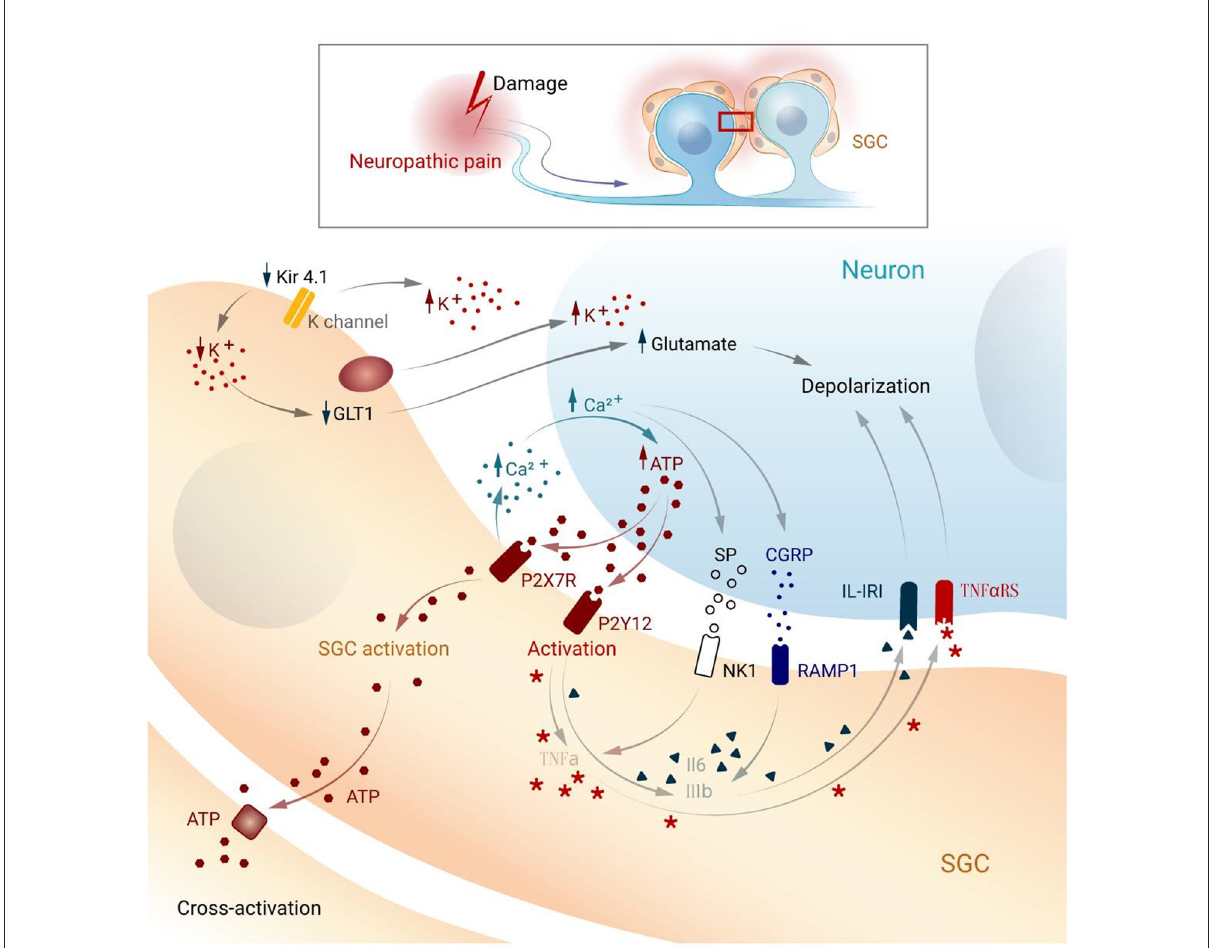
FIGURE2 Possible mechanism underlying activation and cross-activation in SGCs and neurons while pain. SGC, satellite glial cell; Kir4.1, potassium channel; GLT1, glutamate transporter; P2X7R, P2X purinoceptor 7; P2Y12, purinergic receptor; NK1, Neurokinin 1; RAMP1, Receptor activity modifying protein 1; IL1- β , interleukin-1 beta; IK-IR, Interleukin-1 receptor; TNF- α , tumor necrosis factor-alpha; TNFaRS, tumor necrosis factor receptor; CGRP, Calcitonin gene-related peptide; SP, Substance